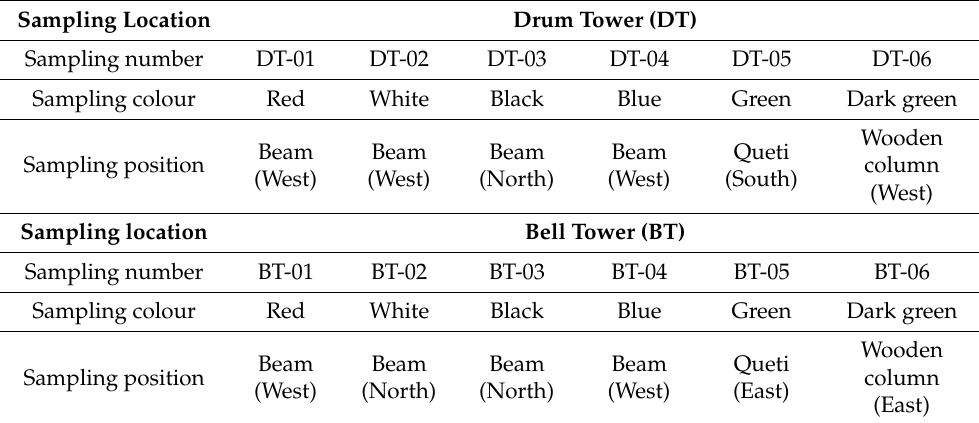
Table 1. Details of samples collected from the Bell and Drum